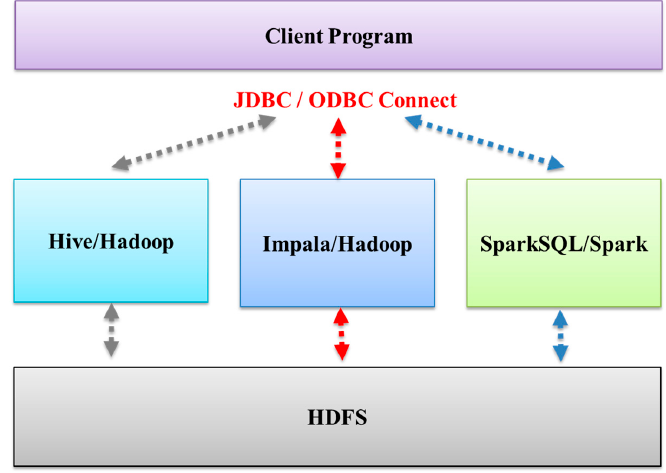
Figure 1. Multiple big data processing tools. JDBC: Java Database Connectivity; ODBC: Open Database Connectivity.